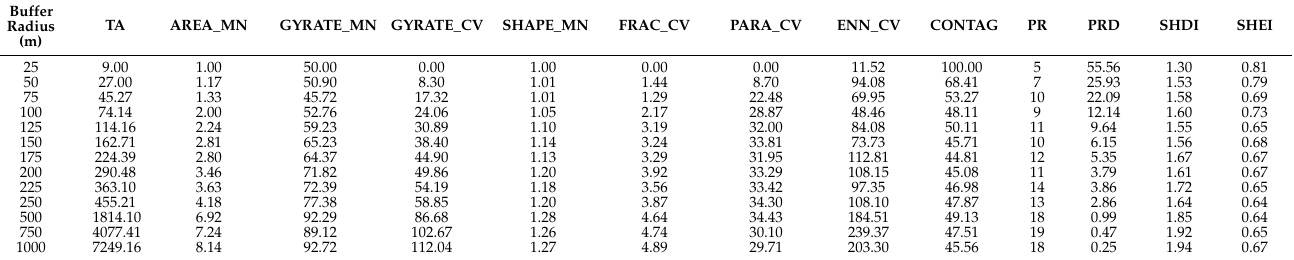
Table 1. Landscape indices in different buffer radius.